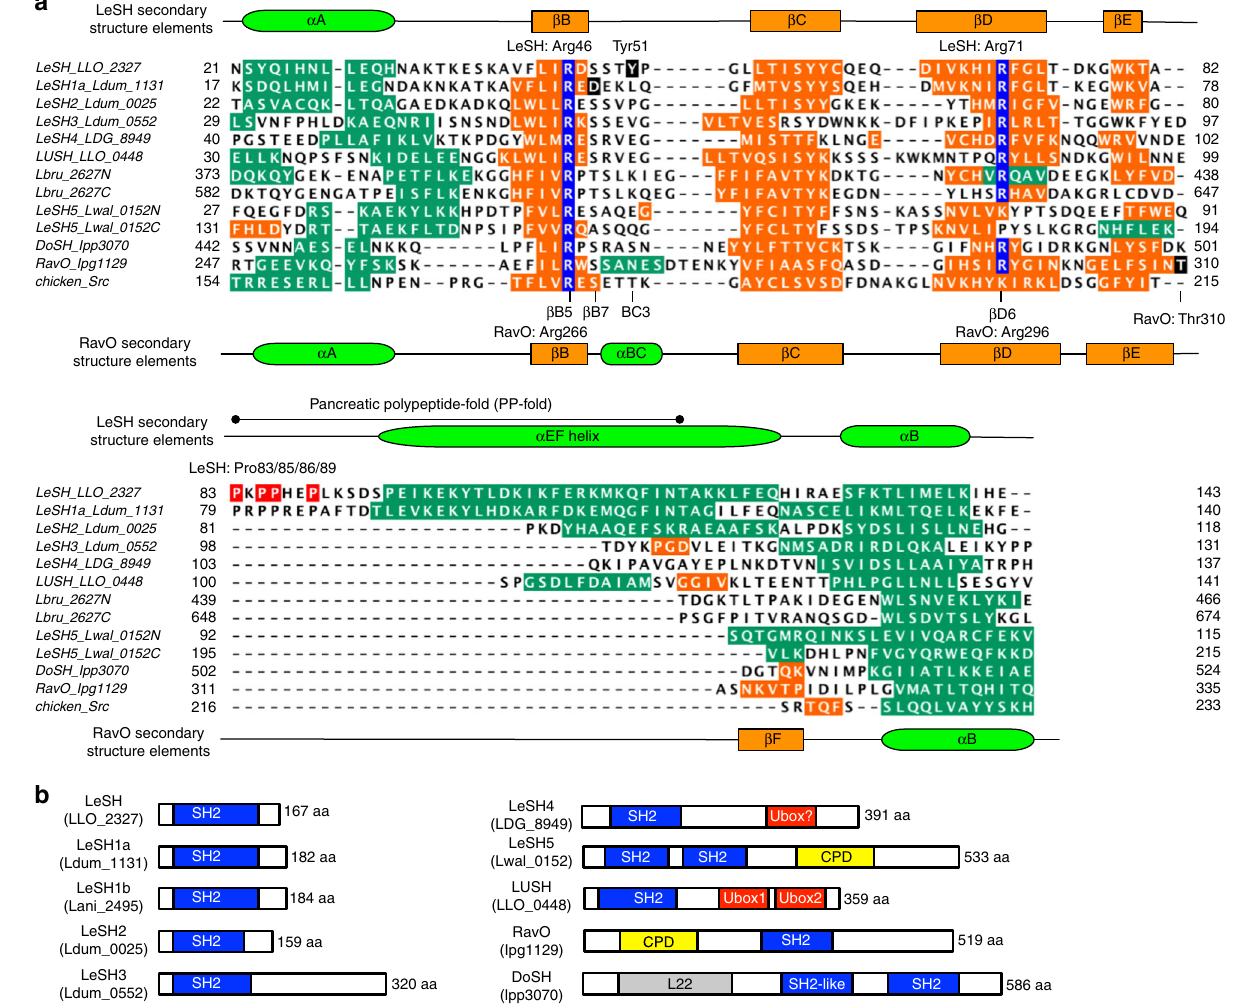
Fig. 1 Legionella encodes a preponderance of SH2 domains. a Structure-guided sequence alignment of the Legionella SH2 domains. Shown are the SH2 domains from the L. longbeachae LeSH and LUSH; L. dumof fi i LeSH1a, LeSH2, and LeSH3; L. drancourtii LeSH4; L. pneumophila RavO and DoSH (C-terminal SH2); and L. waltersii LeSH5 (Lwal_0152). The SH2 domain structures of LeSH, RavO, and Src were used as templates for the structure-guided alignment. Secondary structure elements are based on either solved (Src, LeSH, and RavO SH2 domains) or predicted structures. The α -helices are colored green and β -strands orange. The Arg residues at the β B5 and β D6 positions (based on secondary structure nomenclature of the Src SH2 domain 32 ) are highlighted in blue. The four Pro residues in the pancreatic polypeptide-fold of LeSH are highlighted in red. b Domain organization of representative Legionella SH2 domain-containing proteins. CPD, cysteine protease domain 13 ; L22, uncharacterized Legionella effector domain